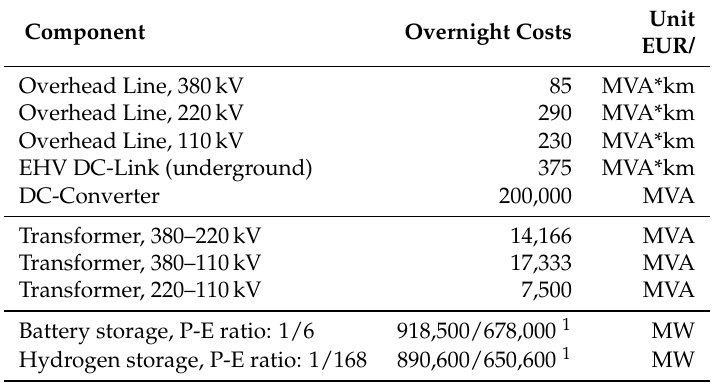
Table 1. Grid and storage expansion parameters for the scenarios NEP 2035 and eGo 100 1 based on [67] (storage units), [3] (HV grid) and [7] (EHV